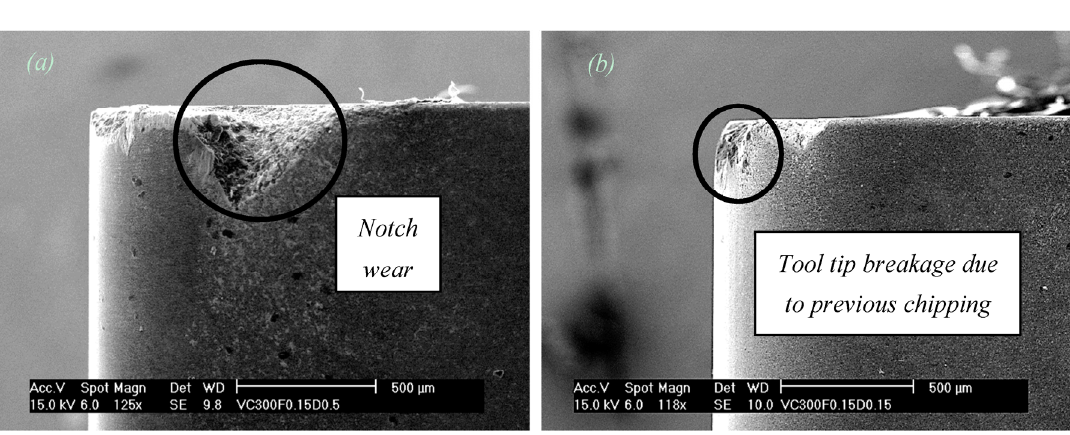
Figure 9. SEM images of the PCBN tool supplied by Seco corresponding to common types of wear found during the tests: ( a ) depth of cut 0.5 mm; ( b ) depth of cut 0.15 mm. The obtained results indicate that tools with a more robust cutting edge (chamfer honing with a width of 50 μ m or round honing with a radius of 35 μ m) last somewhat longer than tools with a round honing of 25 μ